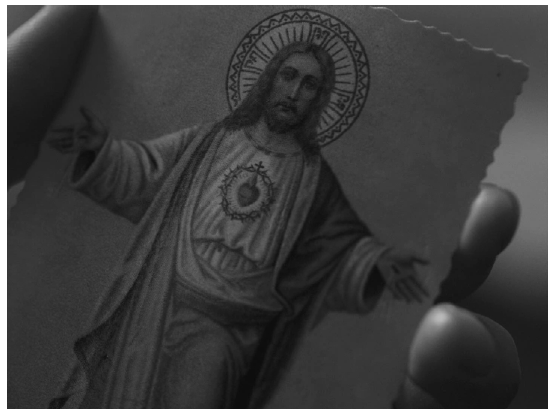
Figure 7. A prayer card used by Ida. Figure 8. The stained glass window.